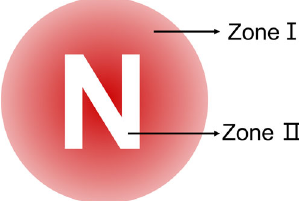
Fig. 5 Illustration of the imaging plate. It can be divided into opaque Zone I and transparent Zone II. Here we only use the character ‘ N ’ to illustrate the imaging plate. Other characters follow the same